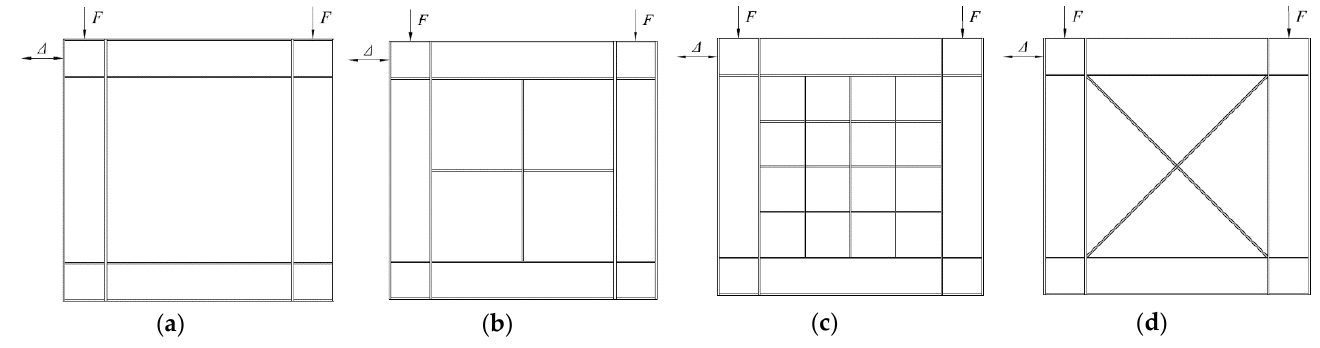
Figure 1. SPSW models with different stiffener arrangements: ( a ) unstiffened; ( b ) 1VHS; ( c ) 3VHS; ( d )